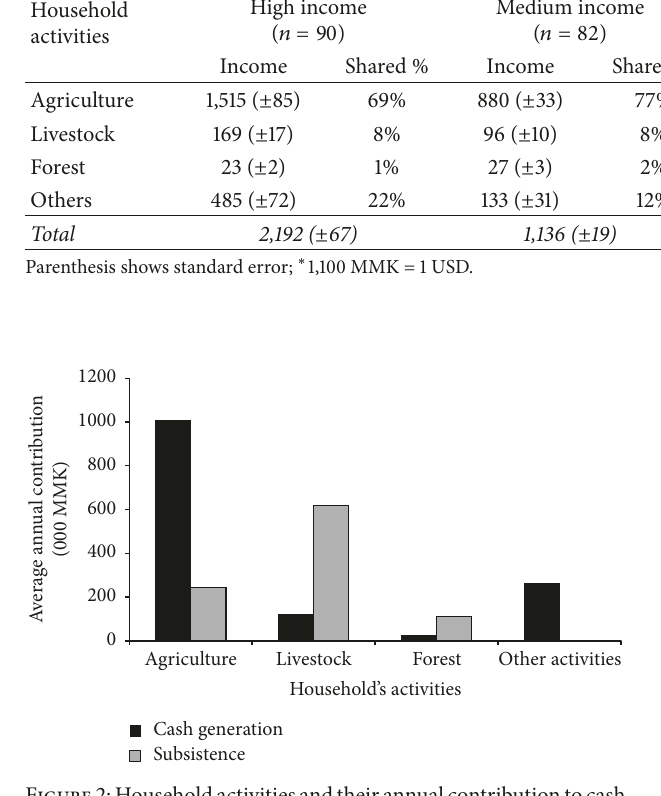
Figure2:Householdactivitiesandtheirannualcontributiontocash generation and subsistence use (MMK,